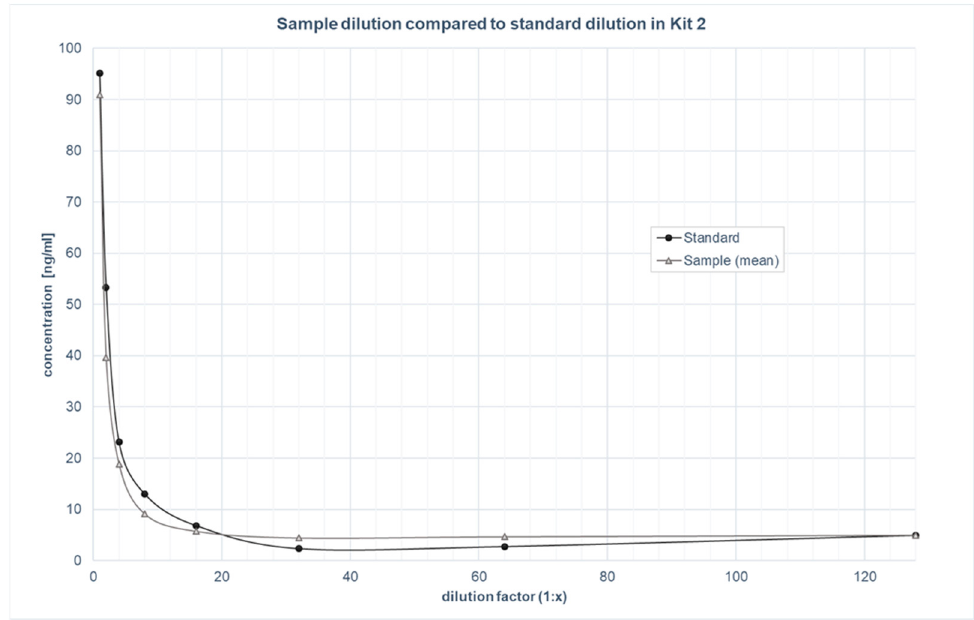
Figure 2. Parallelism: Sample dilution of kit 2, compared to standard dilution.